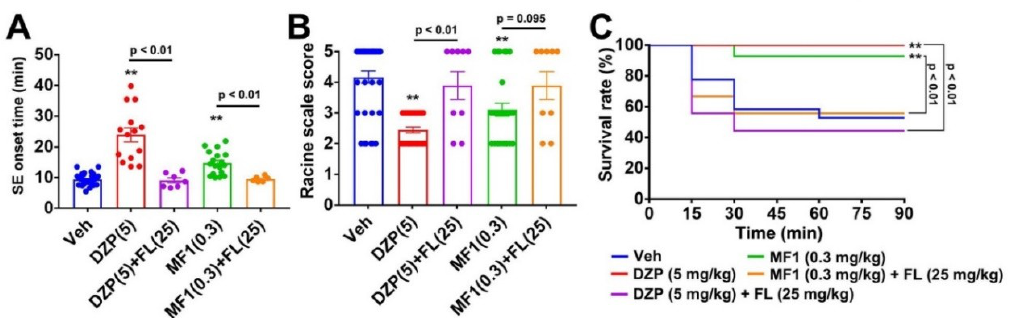
Figure 4. Flumazenil antagonizes the acute effects of MF1 on epilepsy in PILO-treated mice. ( A ), ( B ), ( C ) Treatment with flumazenil (25 mg/kg, i.p.) inhibited the effects of MF1 (0.3 mg/kg, p.o.) and DZP (5.0 mg/kg, i.p.) on ( A ) SE onset time, ( B ) Racine scale score and ( C ) survival rate in PILO-treated mice. Error bars represent SEM. (Vehicle: n = 36; DZP: n = 29; DZP + flumazenil: n = 9; MF1: n = 28; MF1 + flumazenil: n = 9). ** p < 0.01 vs. vehicle-administered PILO-treated mice. DZP (5): DZP (5.0 mg/kg, i.p.) treatment; FL (25): flumazenil (25 mg/kg, i.p.) treatment; MF1 (0.3): MF1 (0.3 mg/kg, p.o.)